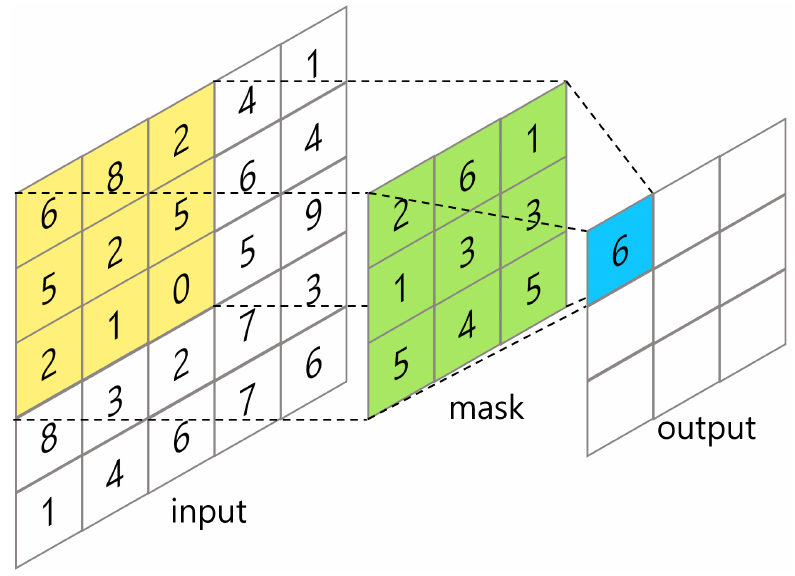
Figure 2. CNN-based learning process including input, mask filter, and